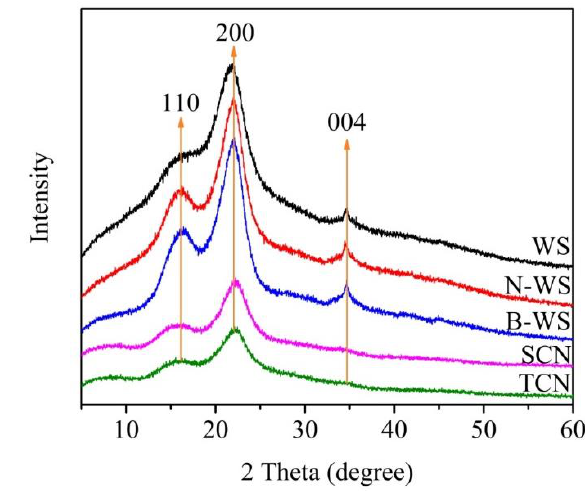
Figure 5. XRD patterns of WS, N-WS, B-WS, TNC, and SNC.